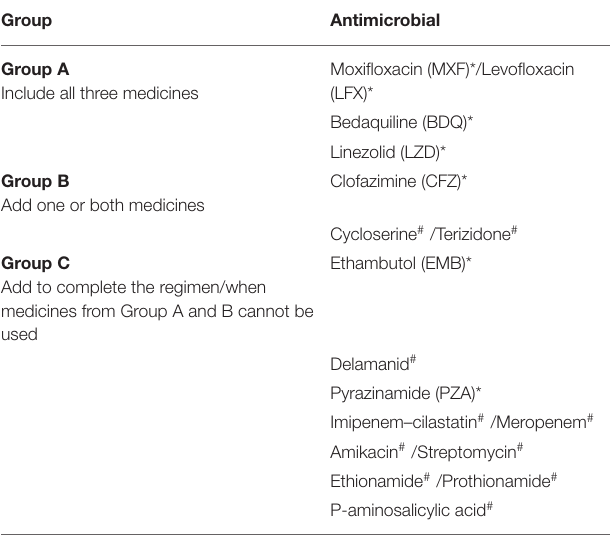
Table adapted from the WHO resource (WHO, 2019b). * Indicates antimicrobials discussed in the current review. # Indicates antimicrobials with unknown effects on mitochondria and bioenergetics of host cells.